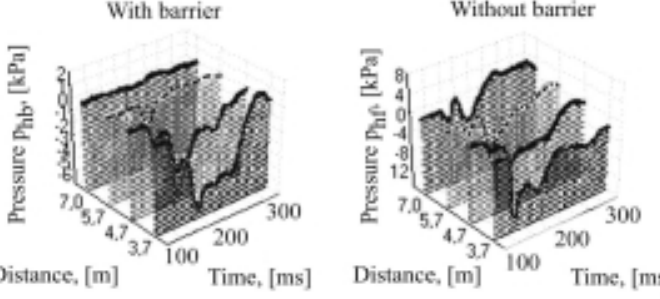
Fig. 22. Comparison of attenuated and unattenuated pressure trends vs. charge-structure distance at measurement depth of 0.95 m by gage no. 2 ( z/D = 0.53).